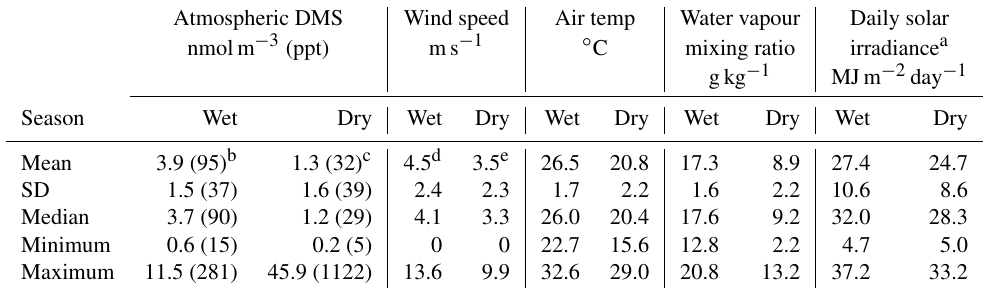
Table 1. Summary of atmospheric DMS and some meteorological data for the 2012 wet season and 2013 dry season campaigns at Heron Island, southern Great Barrier